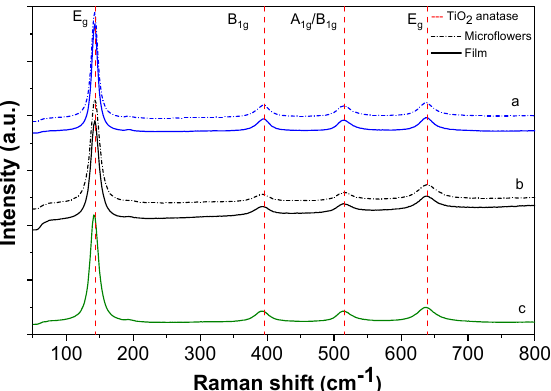
Figure 5. Raman spectra for TiO 2 films deposited by aerosol CVD at ( a ) 550 °C, ( b ) 540 °C, and ( c ) 500 °C. TEM observations show that the coatings are composed of anatase TiO 2 nanograins as deduced from the di ff raction pattern (Figure 6) with a grain size about 10–20 nm.